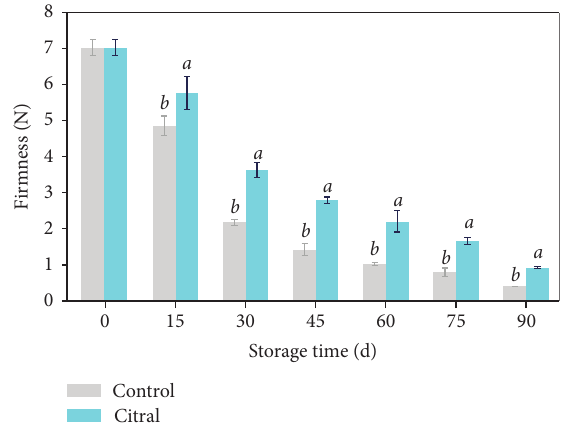
Figure 2: Effect of citral treatment on fresh firmness of harvested kiwifruit stored at 0-1 ° C for 90d. Vertical bars represent the mean ± standard error (S.E., n � 3). Letters indicate the statistical differences according to the independent samples t -test ( p < 0 . 05) on each storage